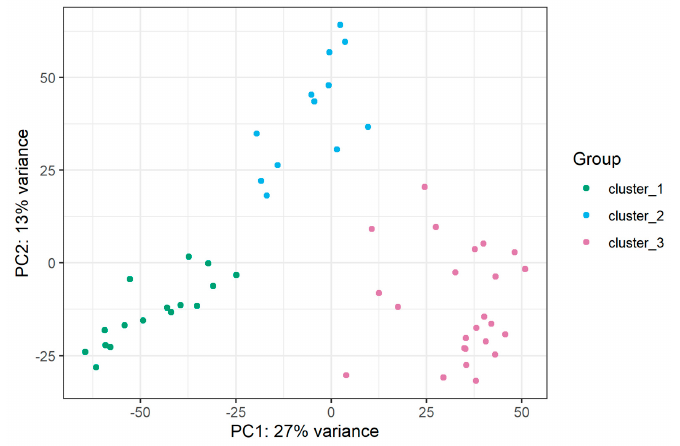
Figure A2. PCA plot based on mRNA sequencing presenting grouping of samples into clusters.